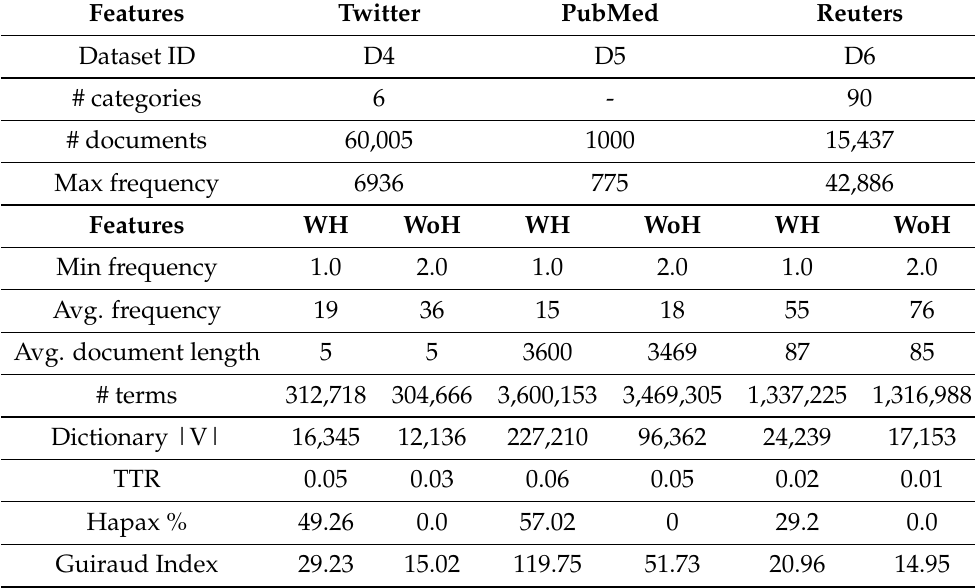
Table 3. Statistical features for datasets D4, D5, and